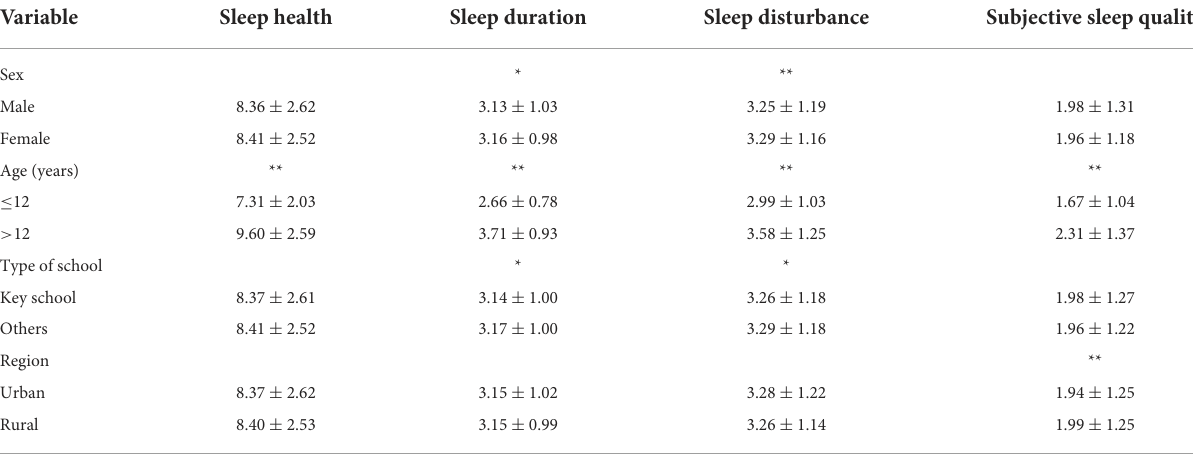
TABLE 2 Comparison of sleep scores by different demographic characteristics.